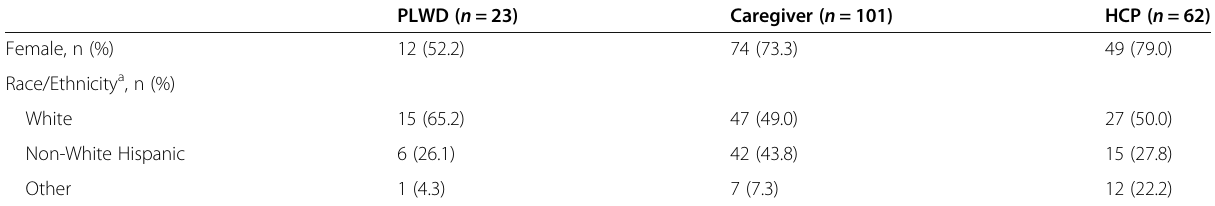
Table 1 Participant Characteristics by Stakeholder